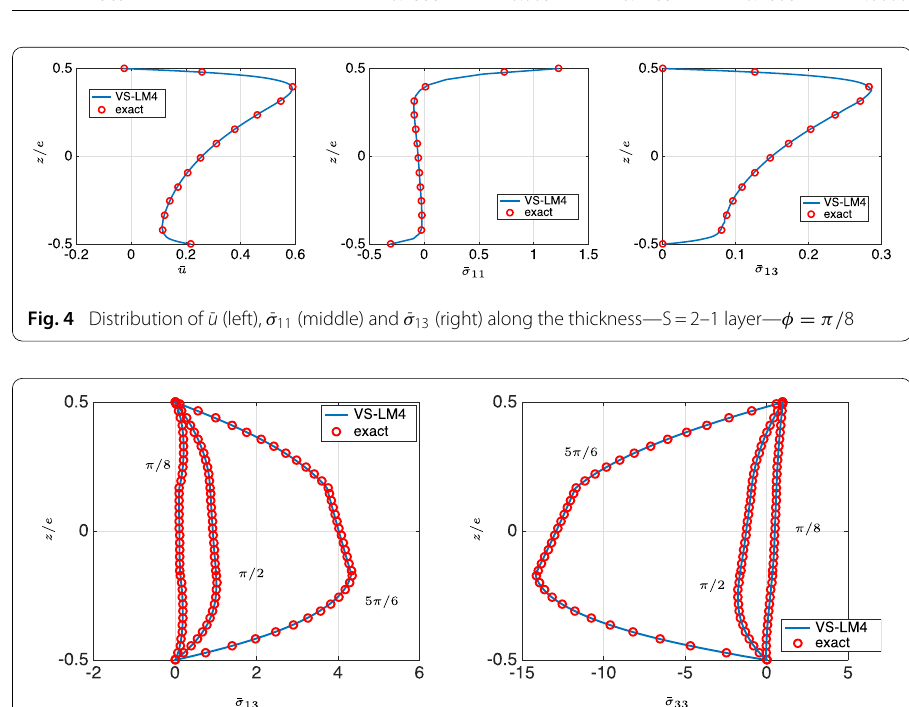
Fig. 5 Distribution of ¯ σ 13 (left), ¯ σ 33 (right) along the thickness—S=4–3 layers— φ = π/ 8 , π/ 2 , 5 π/ 6